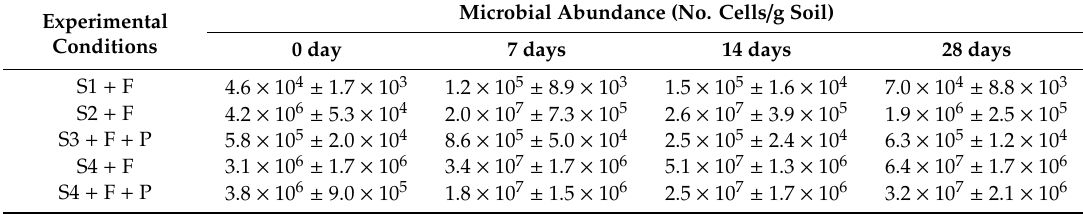
Table 7. Microbial abundance (N. cells / g soil) in soil samples collected from the various microcosms (S1 + F, S2 + F, S3 + F + P, S4 + F, S4 + F + P).